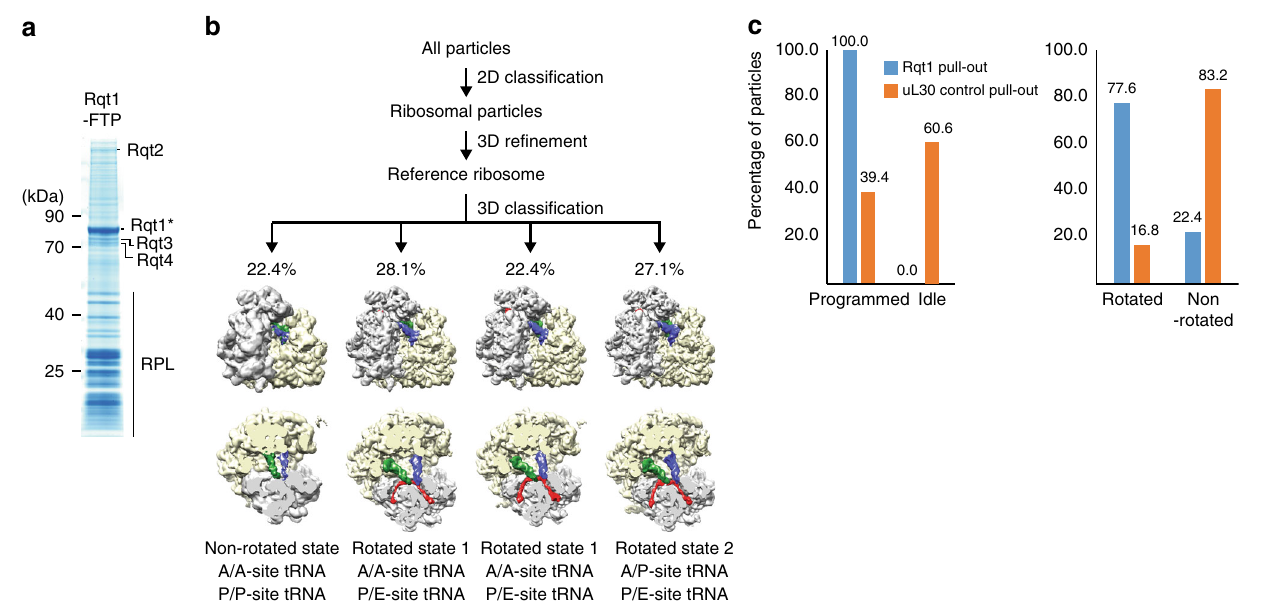
Fig. 6 Rqt1-bound ribosomes are the rotated form with hybrid tRNAs. a CBB-stained SDS gel and Amidoblack-stained blot of pullouts from Rqt1-FTP strains. b Particle sorting was done by 3D classi fi cation in RELION using four classes starting from 142,001 particles. This resulted in three dominant classes with rotated ribosomes (two classes in rotated state 1 and one class in rotated state 2) and one class with un-rotated (classical) state ribosomes; the highest- resolution close-to-focus data set was re fi ned using movie processing (see “ Methods ” section). In total, the data set contained 22.4% classical state